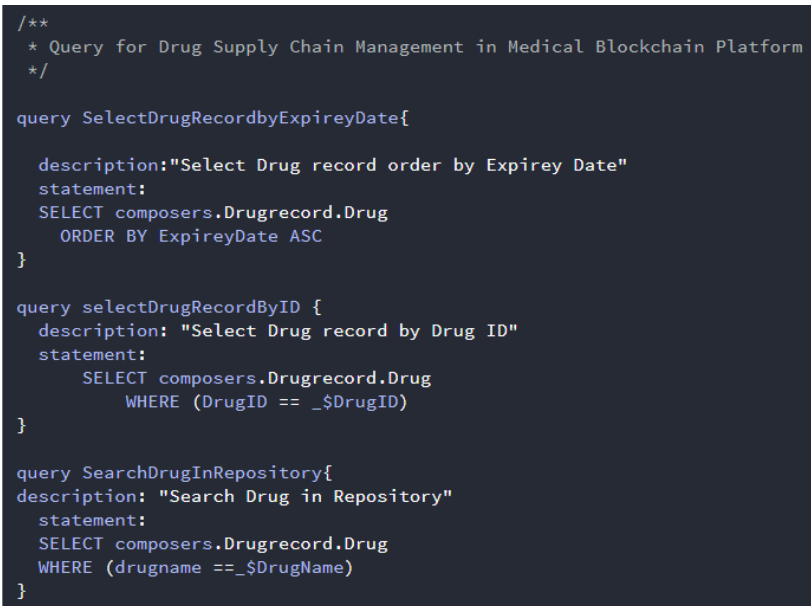
Figure 12. Queries definition in the proposed drug supply chain management in a medical blockchain